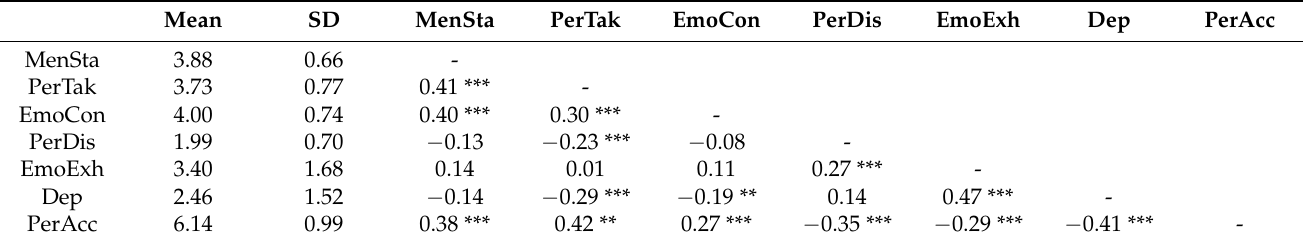
Table 2. Means, standard deviations, and correlations between study